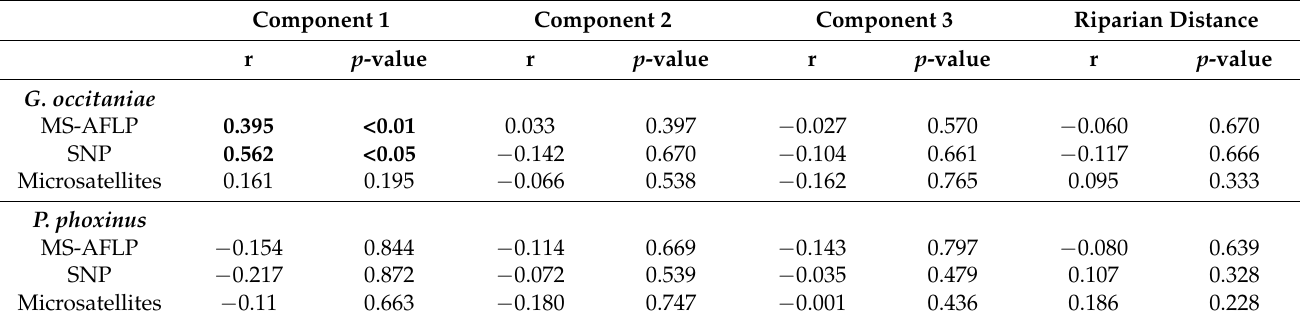
Figure 3. Biplot illustrating the relationship between ( a ) epigenetic differentiation between pairs of populations (based on MS-AFLP) and ( b ) genetic differentiation between pairs of populations (based on SNPs markers) and environmental distances (along a eutrophication gradient) between pairs of sites for G. occitaniae (the red line indicates a significant relationship based on simple Mantel test). Each dot represents a pairwise distance between two sites. Table 4. Summary of simple Mantel tests testing the relationships between epigenetic and genetic pairwise differentiation, environmental (PCA components 1 to 3), and geographical (riparian) pairwise distances in G. occitaniae and P. phoxinus . Results are presented for epigenetic (MS-AFLP) and two genetic (microsatellite and SNPs) markers. Mantel statistics (r) are presented, as well as the associated p -values based on permutation tests with 1000 repetitions. Significant relationships are bolded.